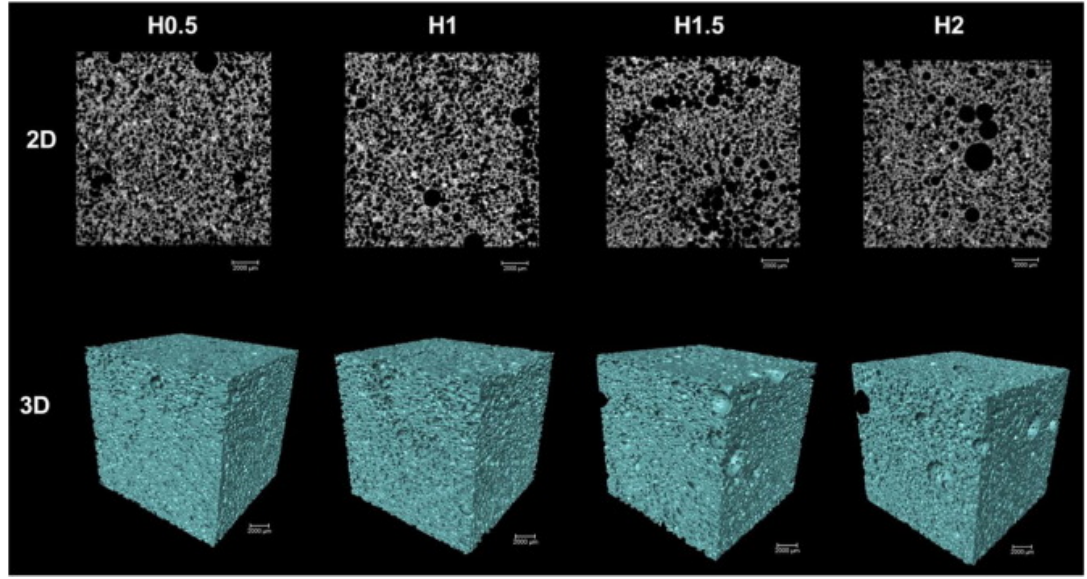
Figure 7. Micro-tomography images of geopolymer foams produced with H 2 O 2 as a foaming agent. Reprinted from Reference [81], © 2020, with permission from Elsevier.